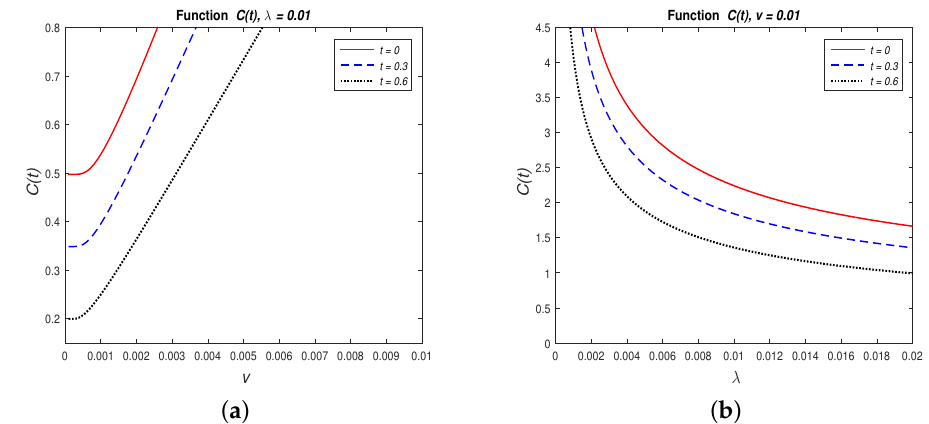
Figure 1. Time evolution of European call option price C ( t ) as a function of v ( a ) and λ ( b ).